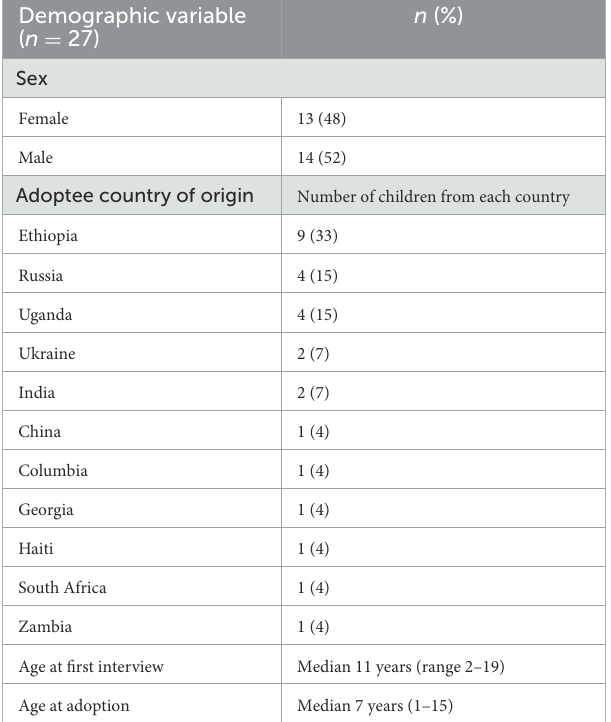
TABLE 2 Adoptee